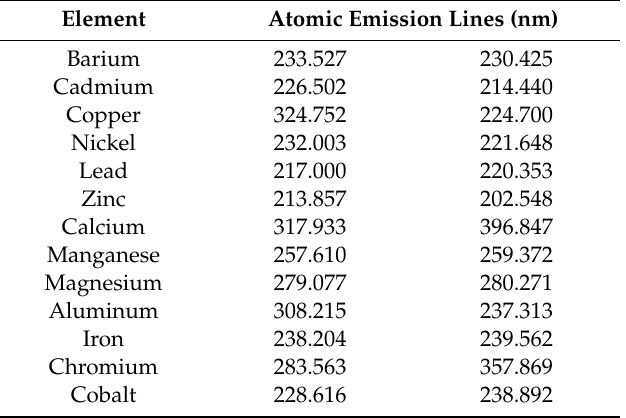
Table 1. Recorded atomic emission lines for each